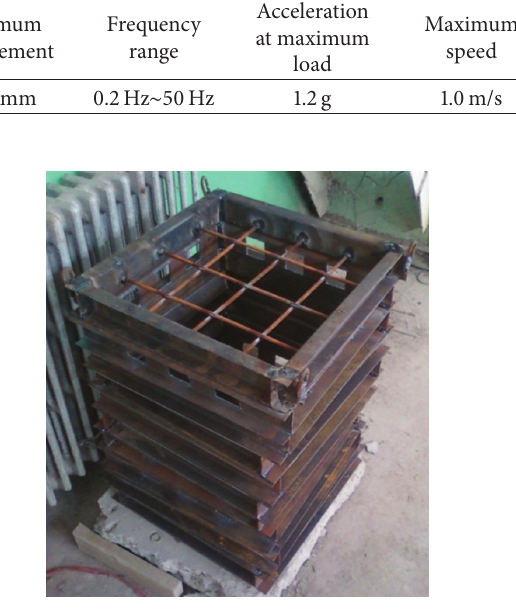
Figure 4: Steel frame of model box.